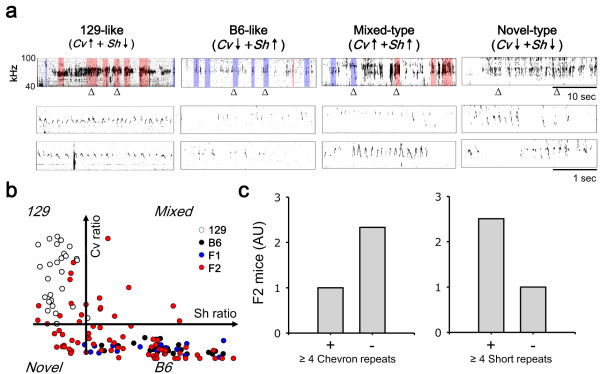
F2 USVs were diversified into B6-like, 129-like, and mixed phenotypes. (a) USV patterns of F2 mice. Representative sonograms of the four types of F2 mice are shown. Chevron repeat (red) and short repeats (blue) are highlighted (box). (b) Proportions of short (x-axis) and chevron (y-axis) for each mouse are shown. One dot is one mouse. Short and chevron compositions for B6 (blue) and F1 (green) overlapped, whereas 129 USVs (red) were discrete. F2 (black) mice were B6-like and 129-like, containing both chevron and short rich repeats, while others lacked chevrons and short syllables. (c) The ratio of F2 mice with syllable repeats greater than four. Chevron-rich USVs were recessive, whereas short-rich USVs were dominant.